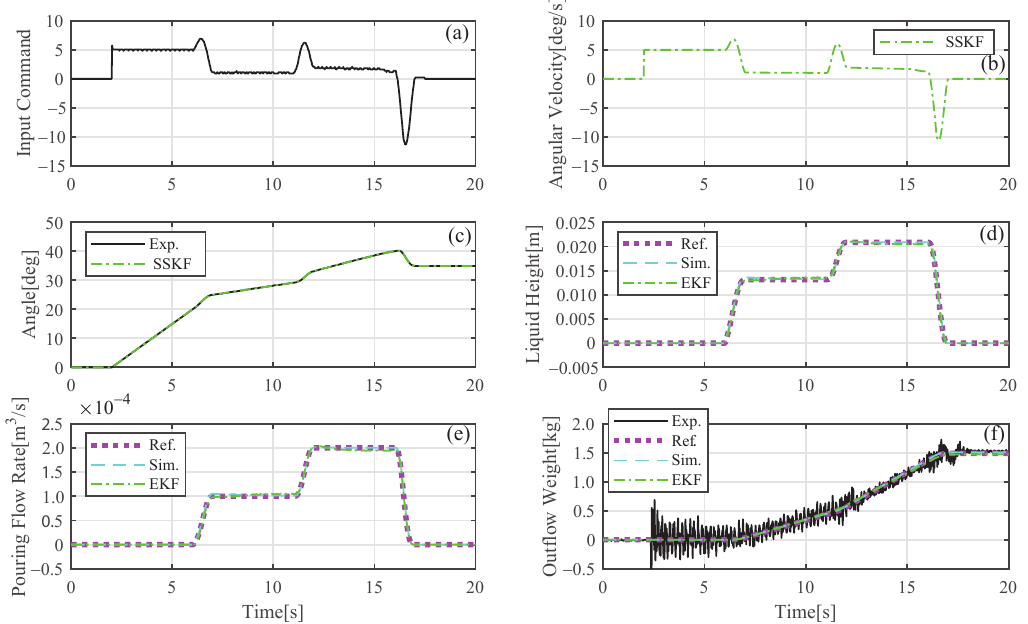
Figure 17. Experimental results using automatic pouring machine (tilting angle error at the start of liquid outflow: + 0 deg). ( a ) Input command to motor for tilting ladle; ( b ) Angular velocity of tilting ladle; ( c ) Angle of tilting ladle; ( d ) Liquid height on pouring mouth; ( e ) Flow rate of outflow liquid from ladle; ( f ) Weight of outflow liquid from ladle.